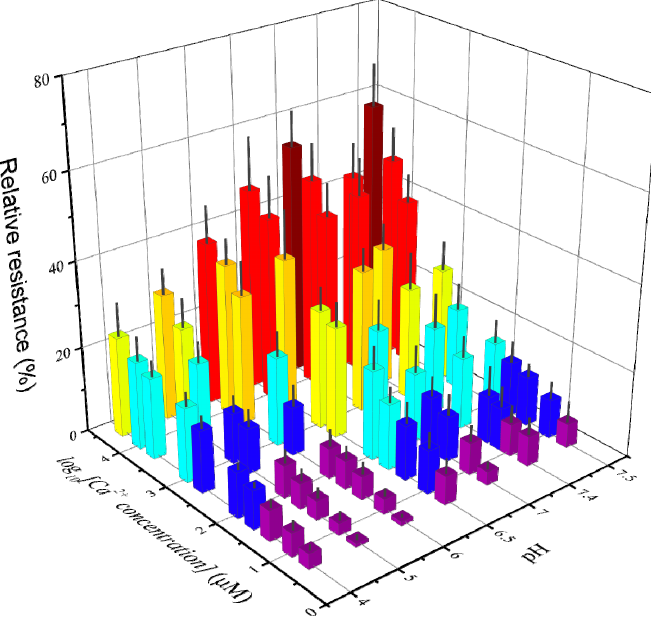
Figure 10. The relative resistances of the GCE/SWNTs/DNAzyme after exposure to different Ca 2+ concentrations with various pH value. (The ratio of pH vs. Ca 2+ concentration: 4.0–5, 4.0–10, 4.0–25,